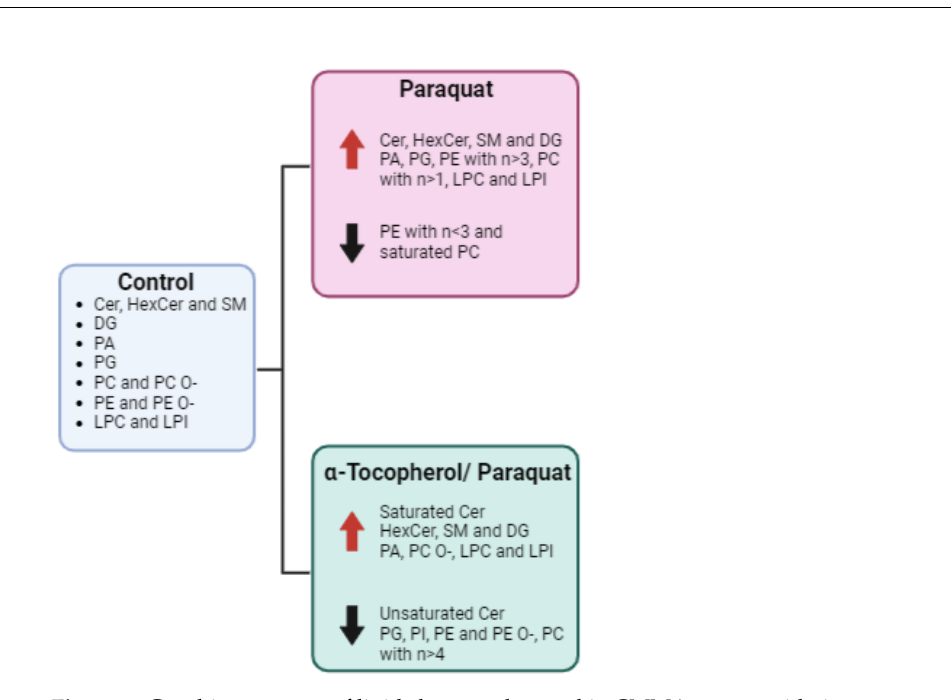
10 of 15 and LPI shown in C. Abbreviations: Ceramides (Cer), hexosylceramides (HexCer), spingomyelins (SM), glycerophosphatidic acid (PA), glycerophosphoethanolamine (PE), glycerophosphoglycerols (PG), glycerophosphocholines and lysophosphocholines (PC and LPC), glycerophosphoinositols